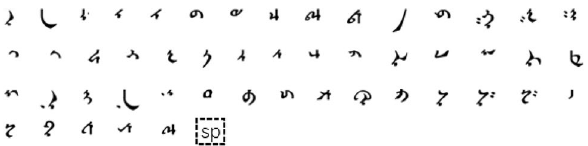
Figure 1. Grapheme